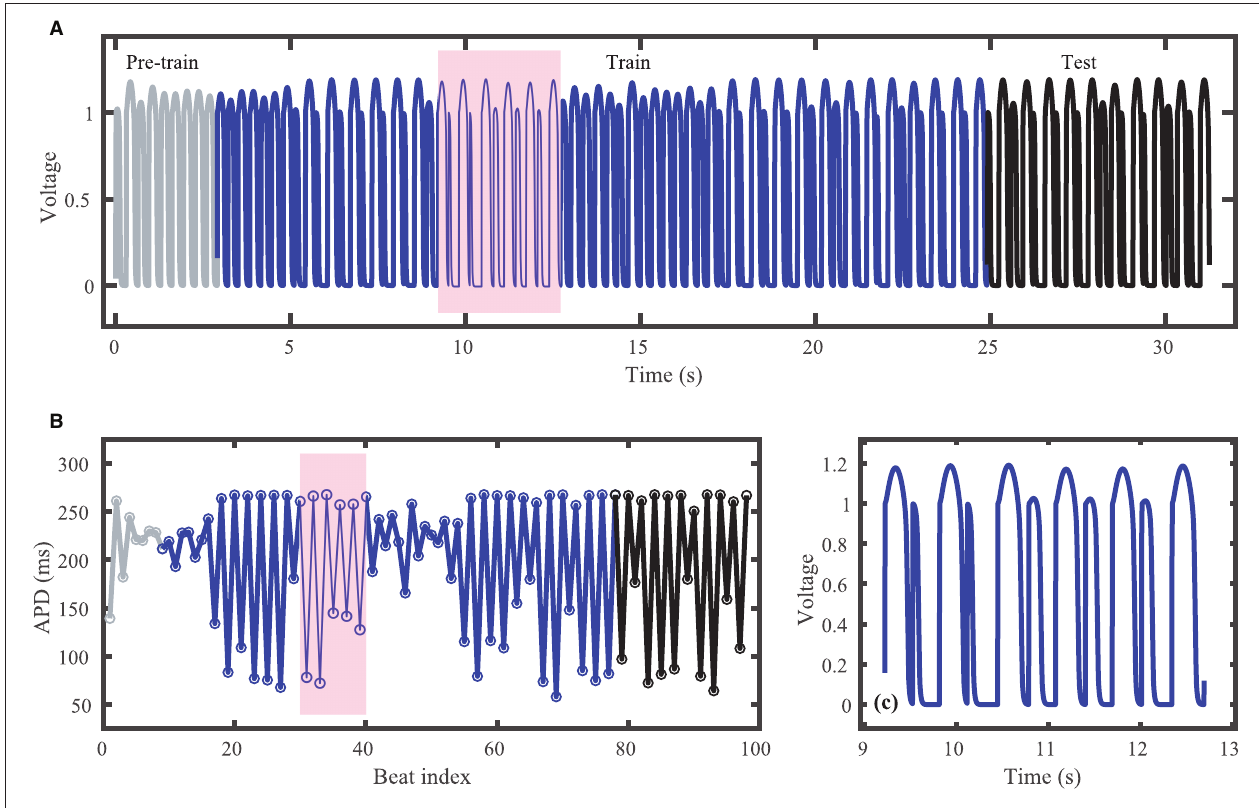
FIGURE 1 | Synthetic action potential time series generated by the Fenton-Karma (FK) model with randomly distributed cycle lengths. (A) Voltage time series including unused pre-training data (gray), training data (blue), and testing (prediction) data (black). (B) Corresponding APDs, following the same color scheme as (A) . (C) Zoomed in voltage trace corresponding to the shaded region in (A,B) showing the irregular action potential shapes and